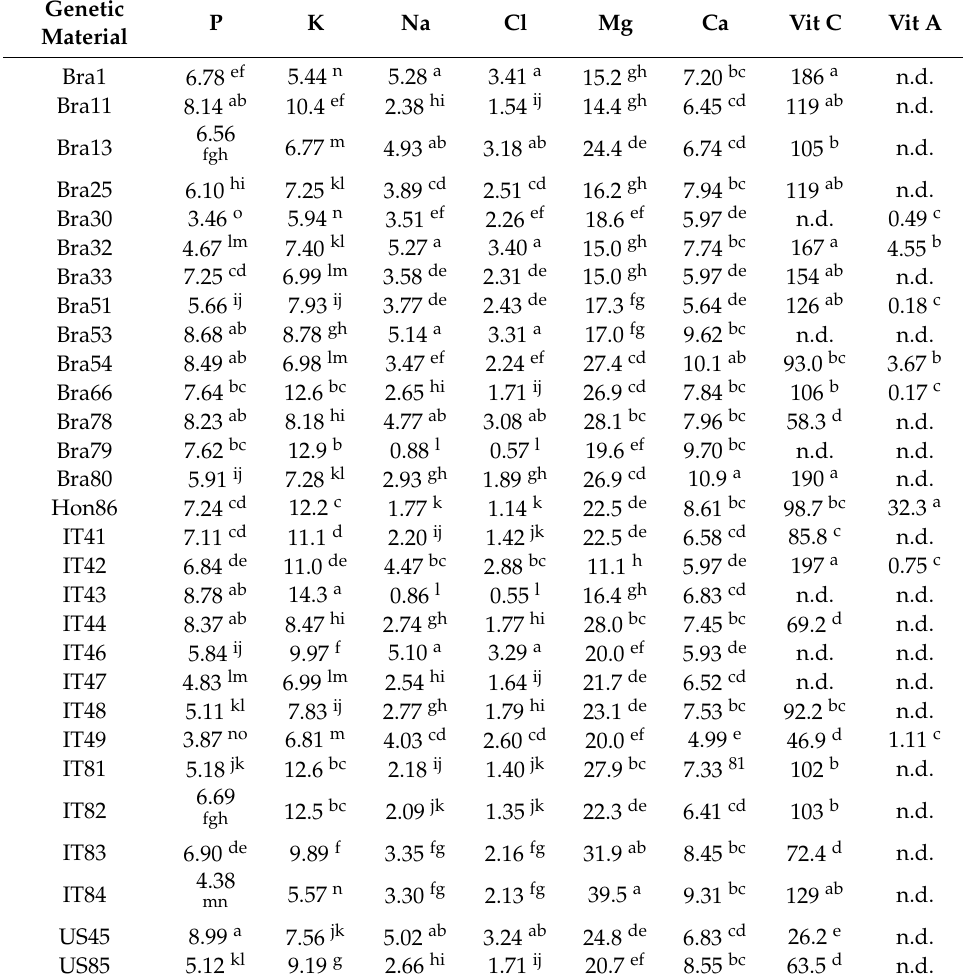
Table 3. Percentage of the contribution to the daily value of minerals and vitamins based on 100 g fresh sweet potato consumption per day for the different accessions according to adults’ needs (European Food Safety Agency